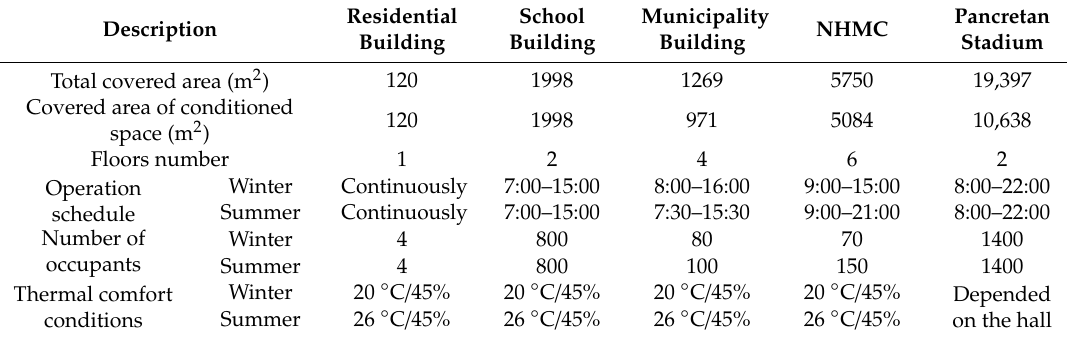
Table 2. Fundamental features regarding the size, the occupants, the thermal comfort conditions and the operation schedule of the examined